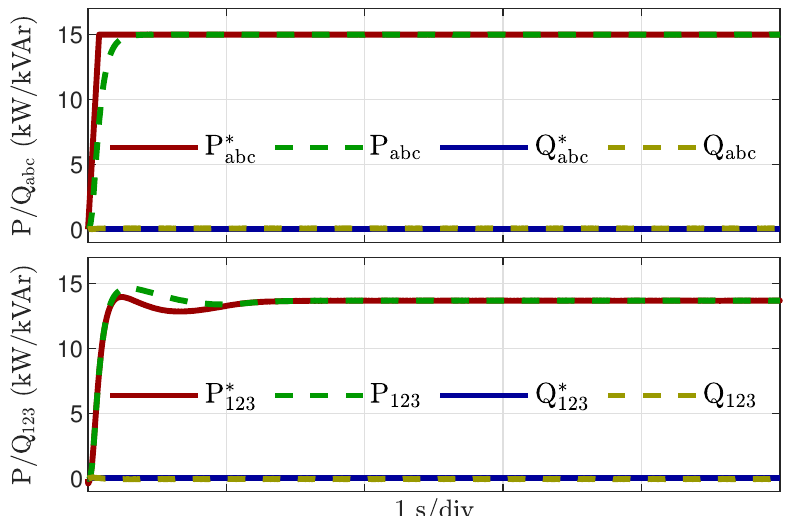
Figure 18. Test Case II: Comparison of ( P ∗ NLC modulation.